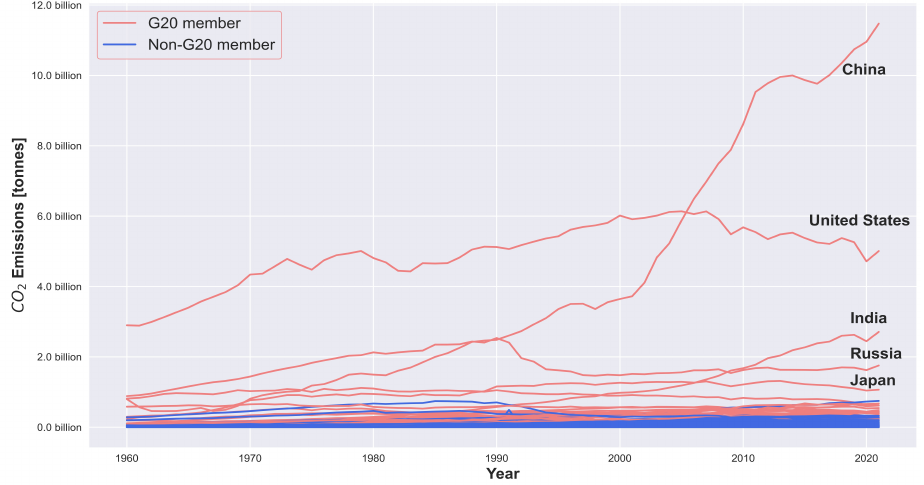
Figure 1. CO 2 emissions of G20 members and Non-G20 members [5].